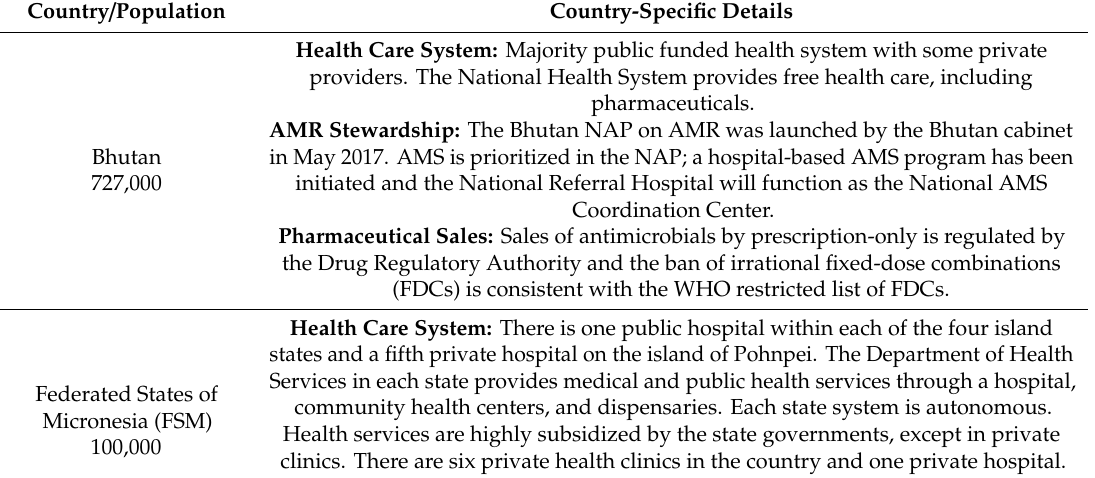
Table 1. Information on Health Care Systems, AMR Stewardship, and Pharmaceutical Sales by Country. Country /